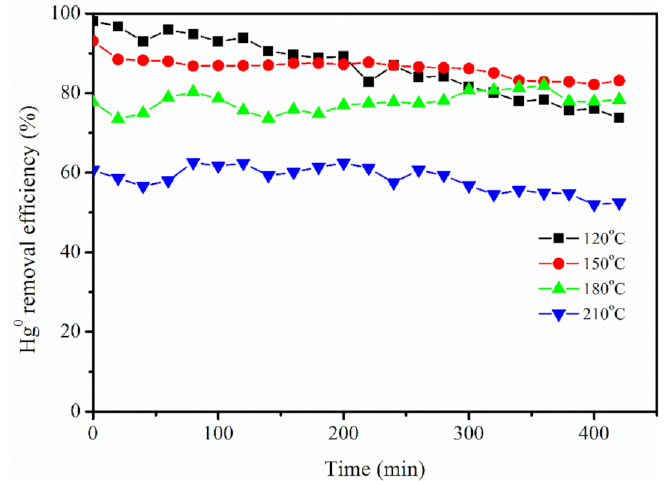
Figure 1. Effect of temperature on Hg 0 removal over 5V 2 O 5 /PG (reaction conditions: O 2 = 8%,